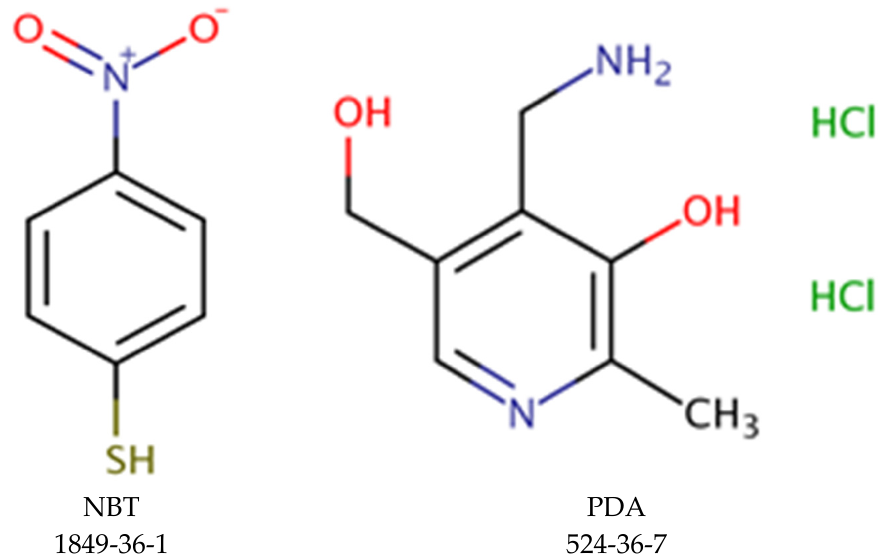
Figure 1. Chemical structure of probe molecules.